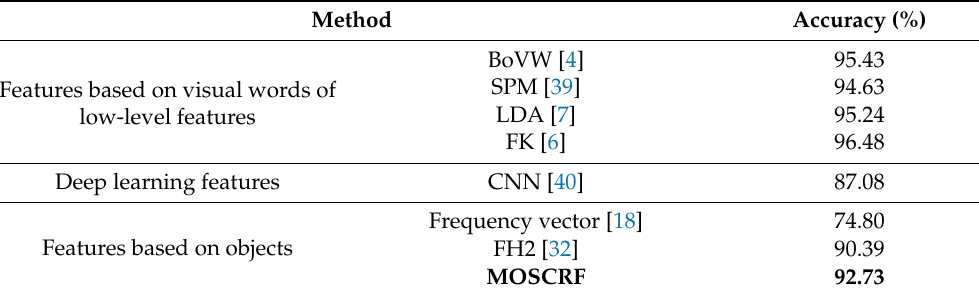
Table 1. Accuracies of the different methods for the USGS dataset.